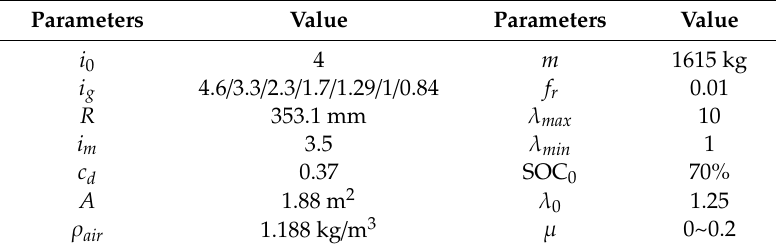
Table 4. P3 HEV configurations in simulation